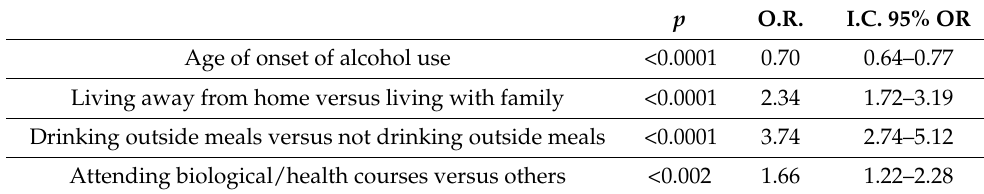
Table 1. Multiple logistic regression analysis: factors associated with drinking habits (risky consump- tion versus low risk